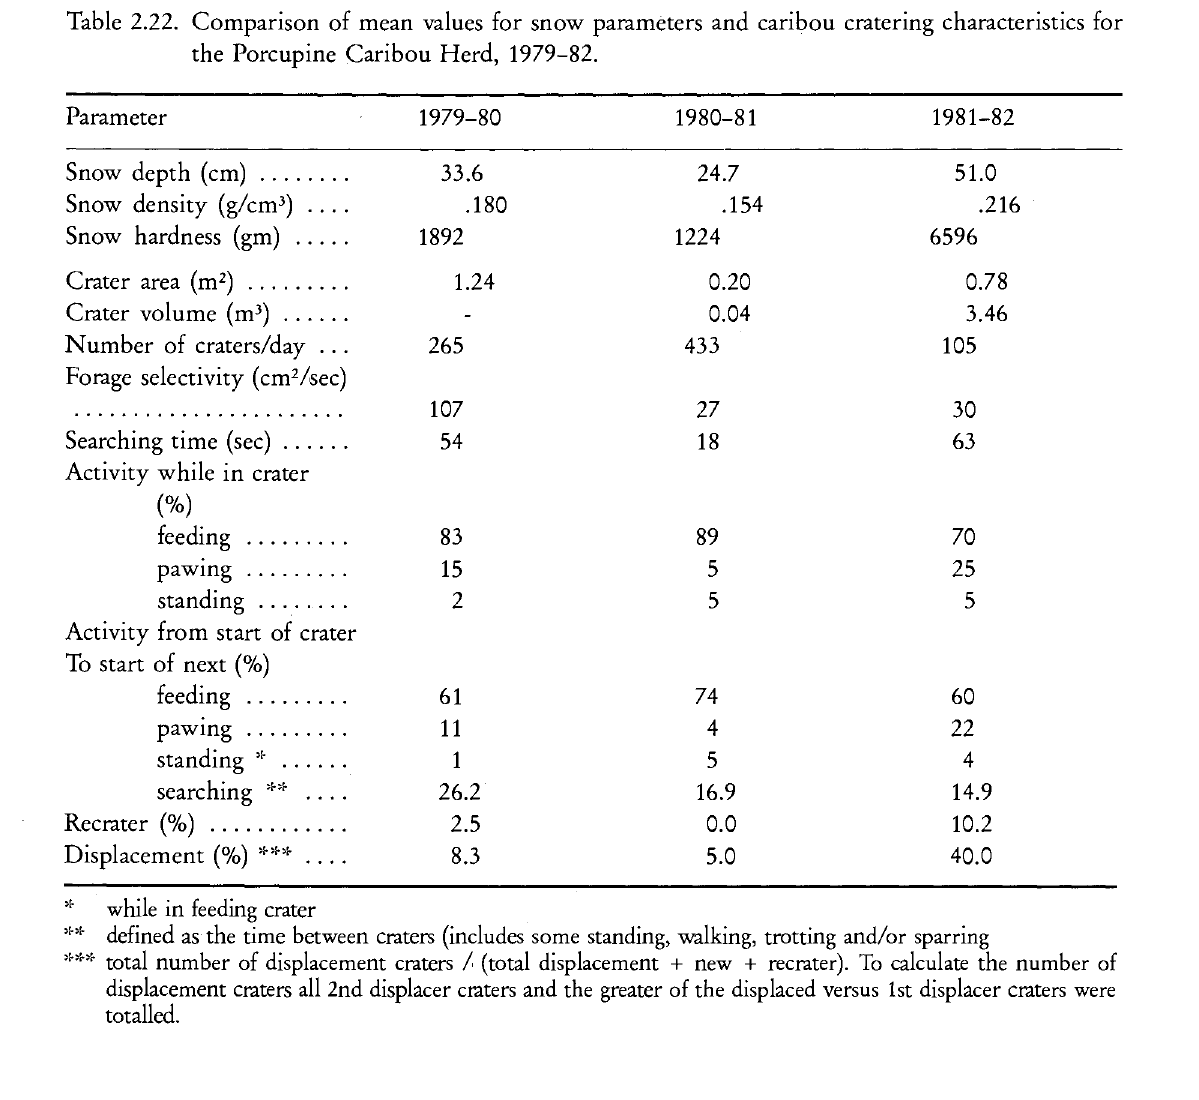
Table 2.22. Comparison of mean values for snow parameters and caribou cratering characteristics for the Porcupine Caribou Herd,